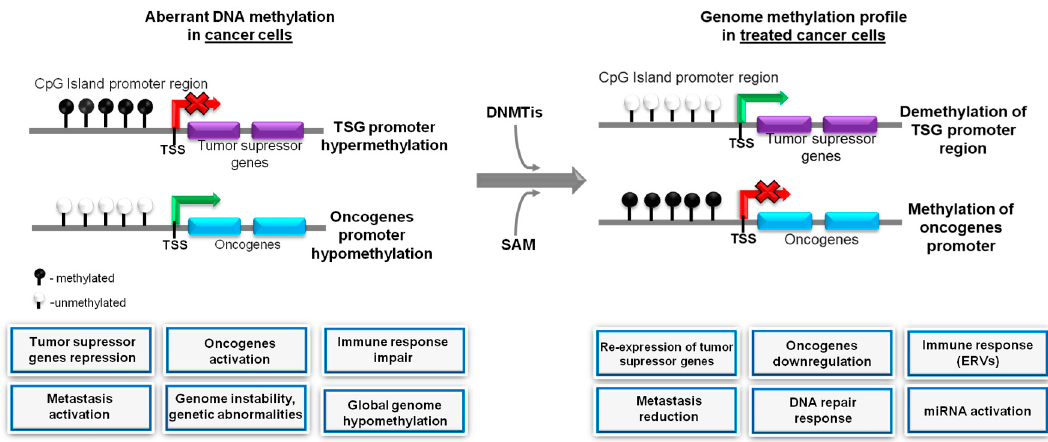
Figure 3. Schematic anti-cancer mechanism of the targeted therapy based on DNA inhibitors and SAM treatment/positive and negative effects of epidrug action . In the cancer genome, DNA hypermethylation and hypomethylation causes the inactivation of tumor suppressor genes and activation of oncogenes, respectively. DNMT inhibitors block hypermethylation of DNA, hence decreasing methylation the promoters of tumor suppressor genes causing upregulation of their expression. On the other hand, SAM can block the activation of oncogenes and proto-oncogenes. Taken together, the combination of these two agents is likely to combat the DNA abnormalities of gene expression seen in cancer.